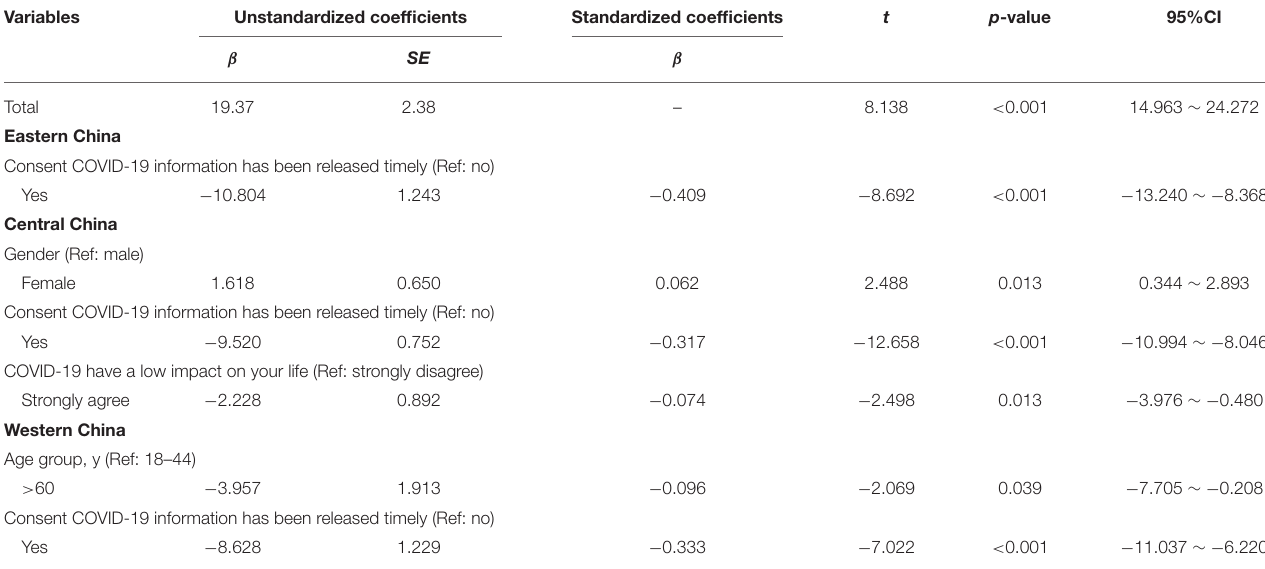
TABLE 3 | Stratified stepwise regression of predictors of psychological resilience by